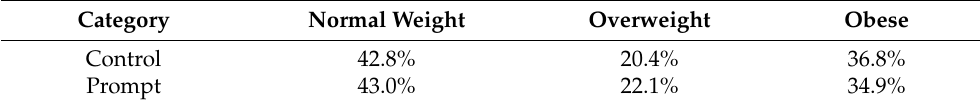
Table 2. Percentage of participants in each BMI category by